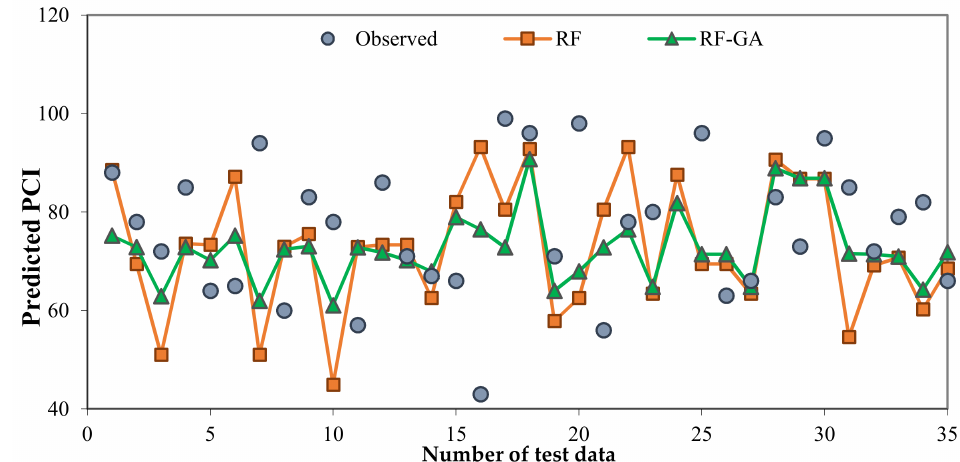
Figure 5. Observed and predicted values of PCI with RF and RF-GA models.